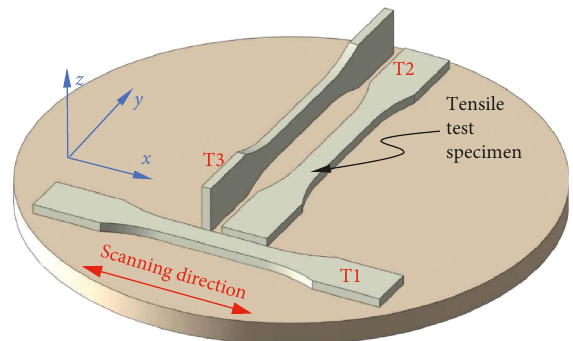
Figure 4: Orientations of tensile test specimens for different scanning vector lengths.